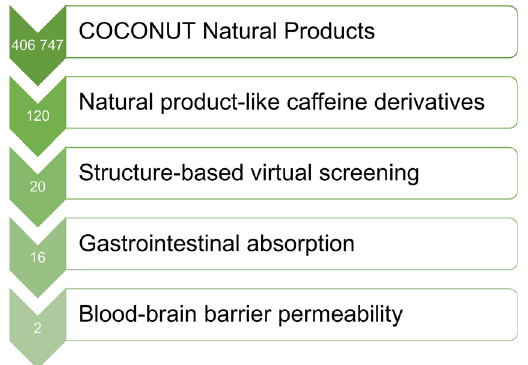
Figure 7: Step-wise structure and ADMET-based screening of the selected natural product-like caffeine